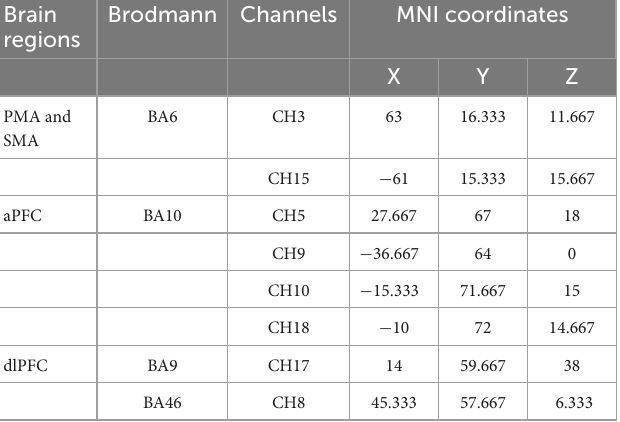
TABLE 2 Corresponding brain regions, Brodmann, channels and coordinates. Brain Brodmann regions